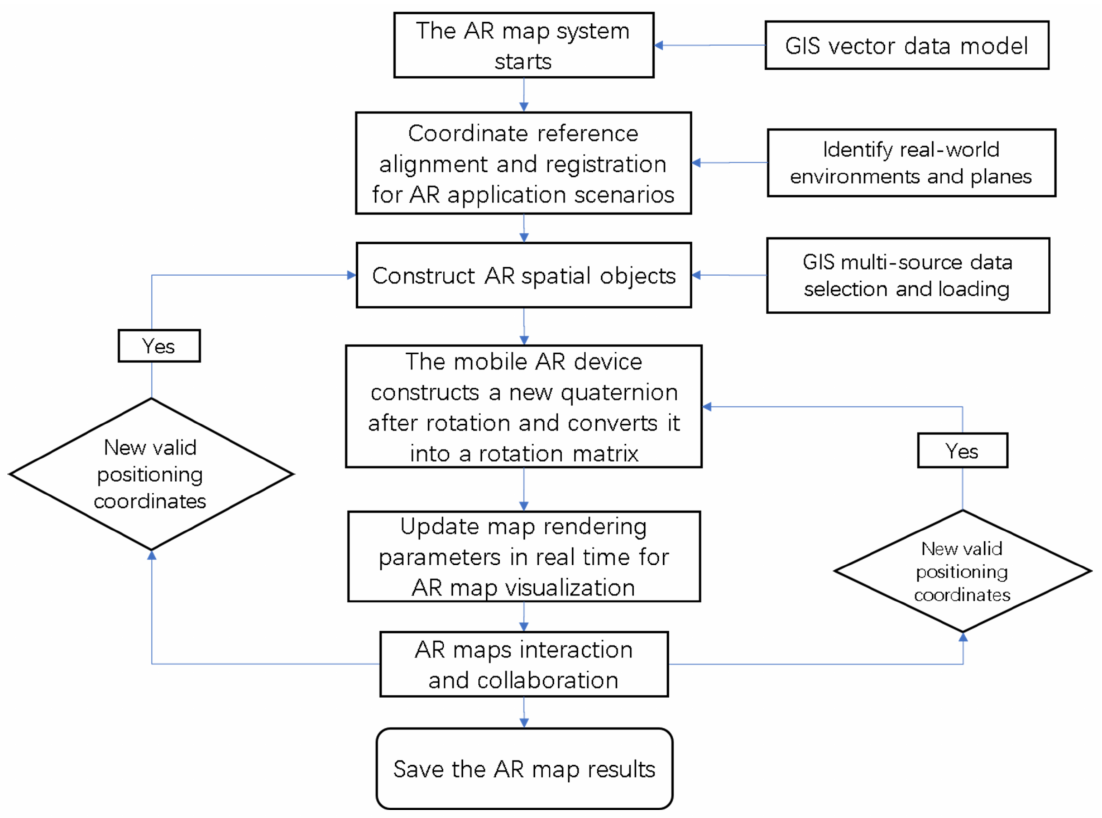
Figure 2. AR vector map visualization core process based on quaternion.